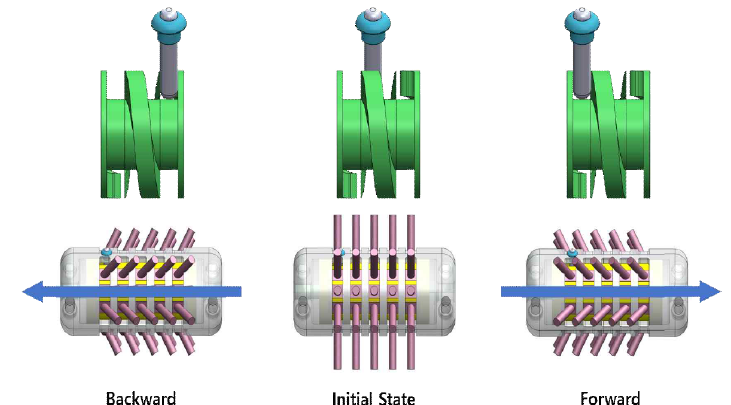
Figure 2. The switch mechanism that enables the HSA to generate vibration and change the leaning direction by a single motor: The pin will be positioned either in the leftmost or rightmost slot of the switch with respect to the rotating direction of the motor, which in turn determines the leaning direction of the spikes. Blue arrows indicate the HSA’s moving direction according to the pin positions.